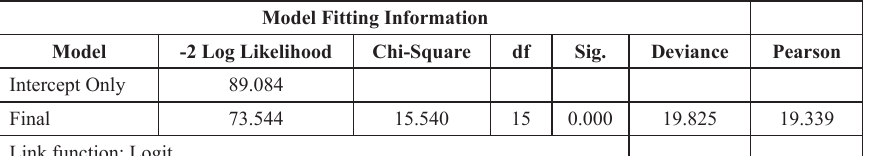
Table 3. The model for student’s